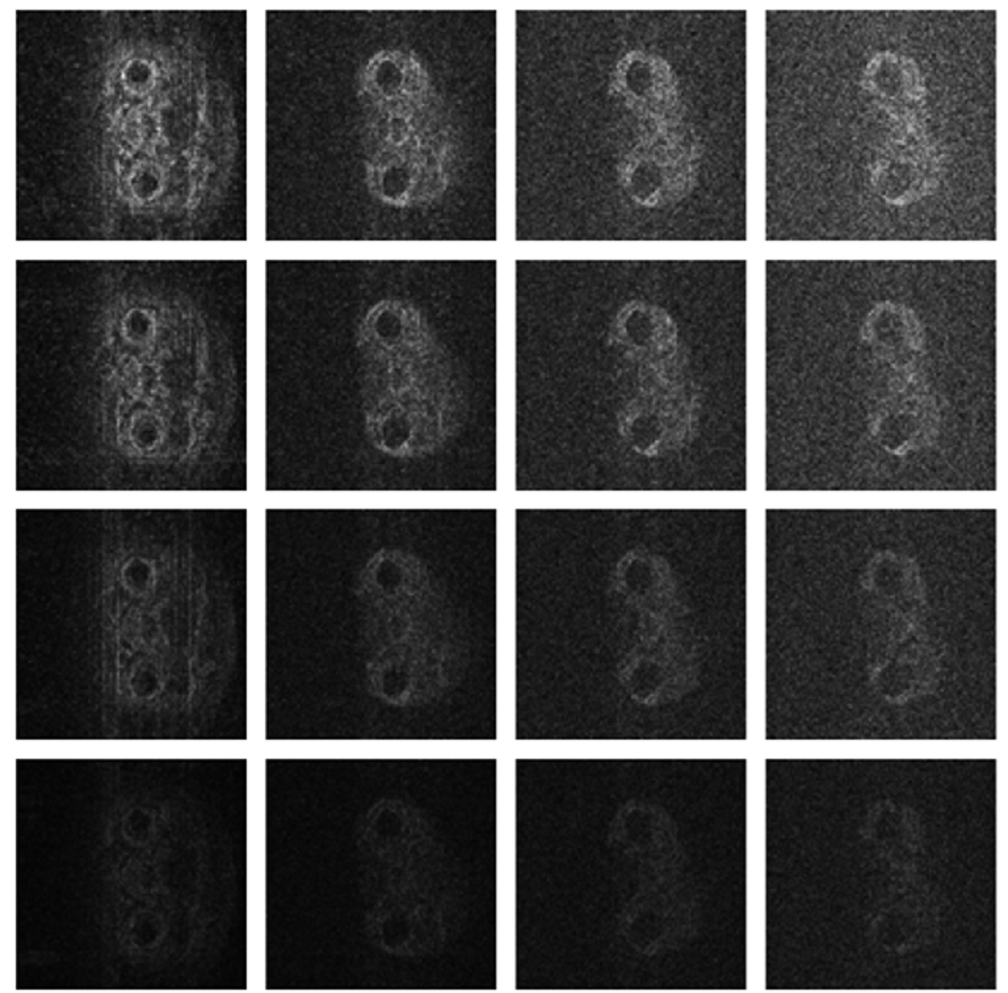
Figure 6. Difference Images from In vivo Reconstruction. Top row—same sampling pattern, row-sparse recovery; 2nd row—same sampling pattern, rank-deficient row-sparse recovery; 3rd row—different sampling pattern, group-sparse recovery; 4th row—different sampling pattern, rank-deficient group-sparse